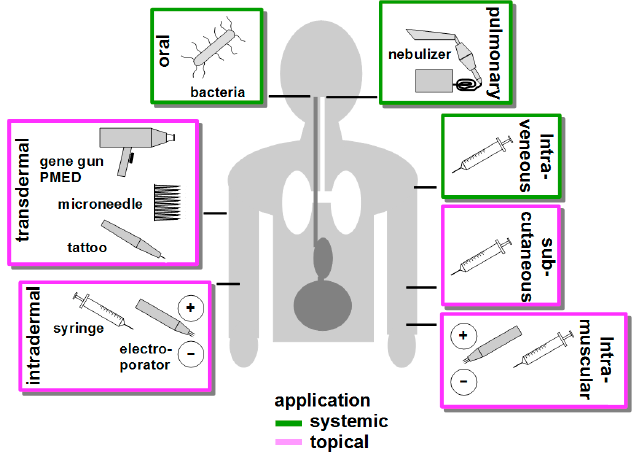
Figure 3. Routes of DNA vaccine delikvery. DNA vaccines may be delivered systemically by intraveneous injection to reach secondary lymphatic organs, by oral application of (attenuated) bacteria as a vehicle to confer uptake of DNA by intestinal APC, and by pulmonary administration of nebulized DNA to achive uptake by lung cells. Transdermal delivery primarily adresses LC, and both needle-free delivery of particle-adsorbed DNA vaccines by helium pressure (gene gun, PMED) and needle-based administration via microneedles and tattoo devices are clinically tested. Transfection of cutaneous APC as well as of non-APC by intradermally injected DNA vaccines is enhanced by immediate electroporation. Subcutaneous injection mainly results in transfection of fibroblasts and keratinocyts, which express transgenes and release antigen for uptake APC. Likewise, intramuscular injection of DNA vaccines primarily yields transfection of myocytes that express/release antigen for APC uptake, and myocyte transfection rates are enhanced by electroportion at the site of injection as